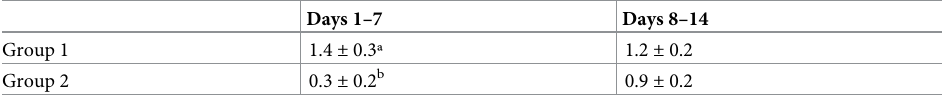
Table 2. Total number of days apparent abnormal defaecation in hamsters fed a basal diet (group 1) and a 1.0 × 10 ⁷ cfu/ml supplement of heat-killed Enterococcus faecalis (group